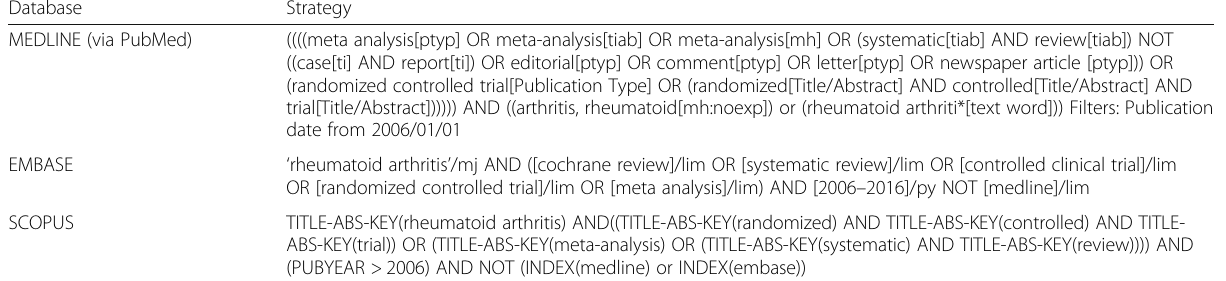
Table 2 Search strategies used in the MEDLINE, EMBASE and SCOPUS databases for obtaining evidence on drug therapies for rheumatoid